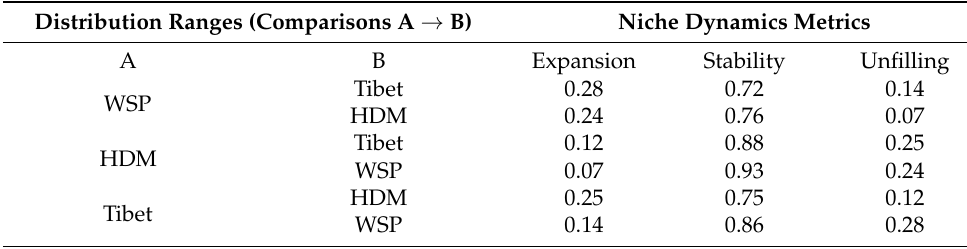
Table 1. Comparisons of the niche dynamics by pairs of the three lineages of Quercus aquifolioides , based on PCA-env